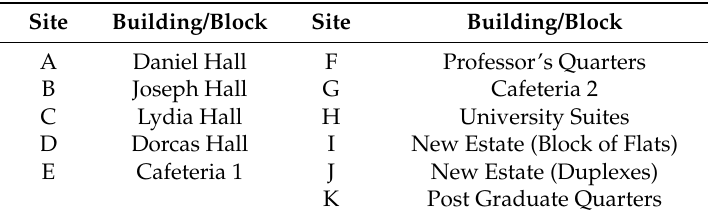
Figure 1. Master plan of the institution. Table 1. Areas marked on the map.